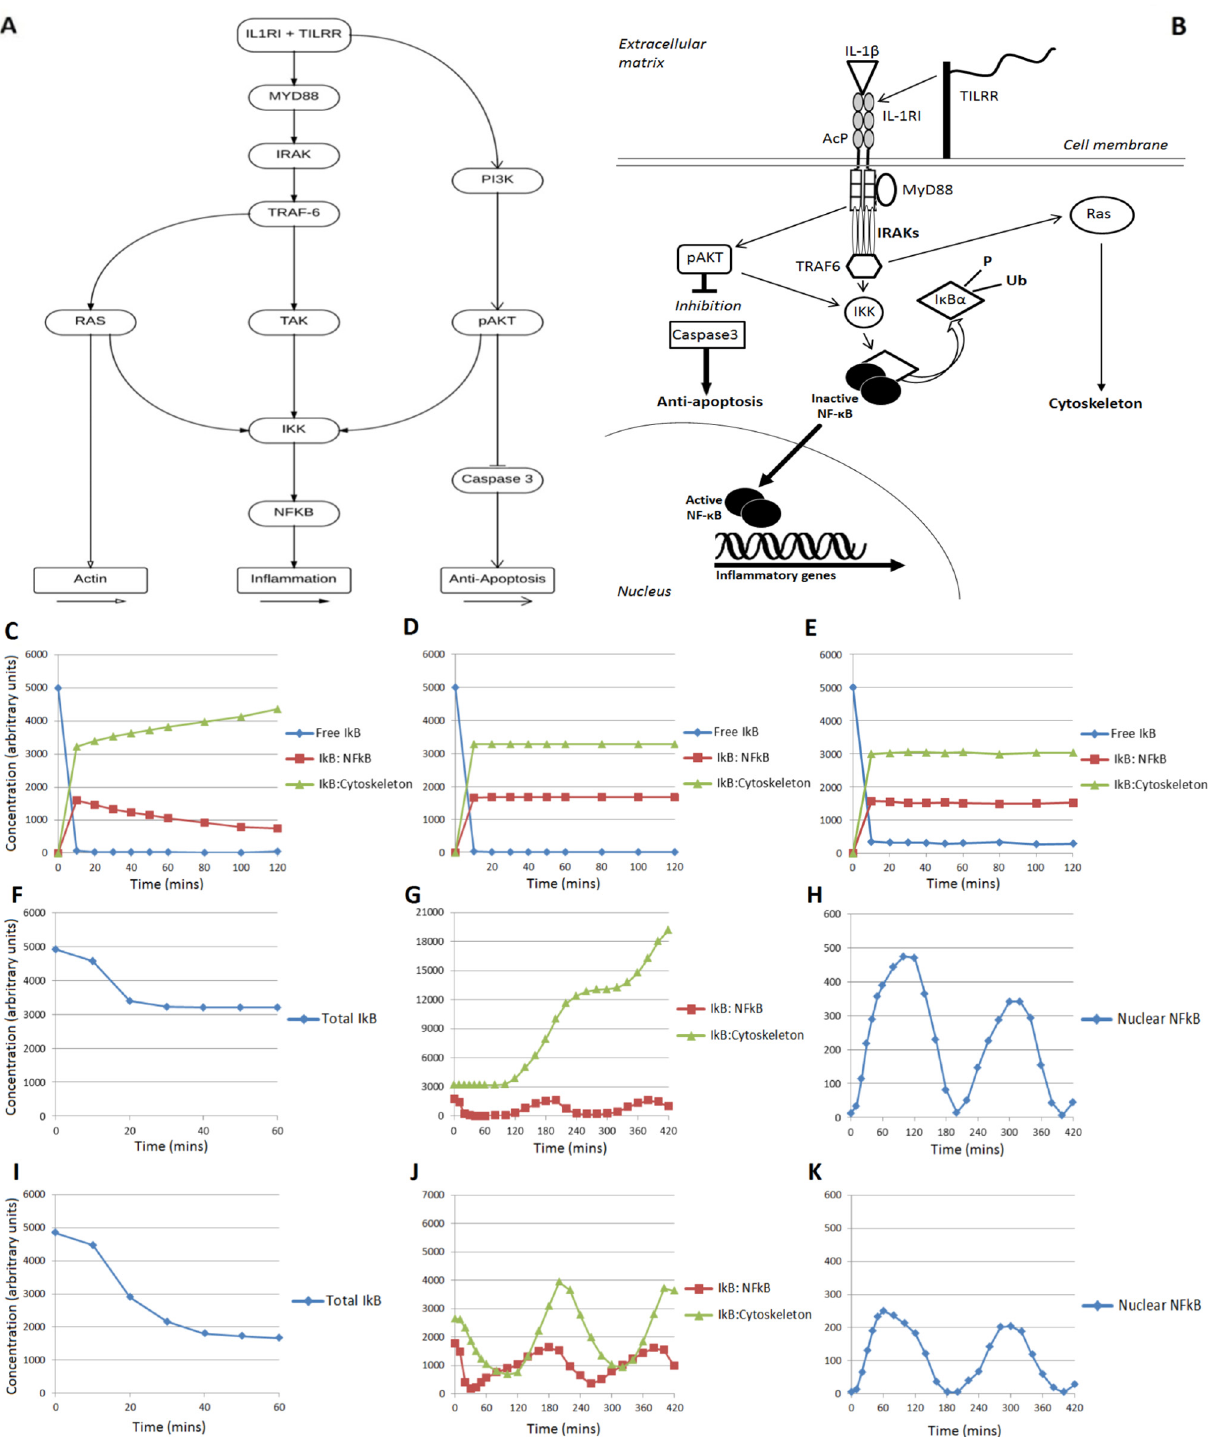
Fig 1. Agent based modelling including binding and release of cytoskeletal I κ B α . A. Flowchart summarising the activation cascade and downstream effects incorporated into the agent based model of the NF- κ B signalling pathway. B. Representation of localisation and movement of selected agents within the agent based model. C, D, E. Simulations of un-stimulated levels show accumulation of I κ B α on the cytoskeleton with dissociation from NF- κ B only (C) but a steady state when I κ B α dissociates from neither (D) or both (E) cytoskeleton and NF- κ B. F-H. Simulations of responses to IL-1 stimulation in the model with dissociation from neither cytoskeleton nor NF- κ B. I-K Simulations of response to IL-1 stimulation in the model with dissociation from both cytoskeleton and